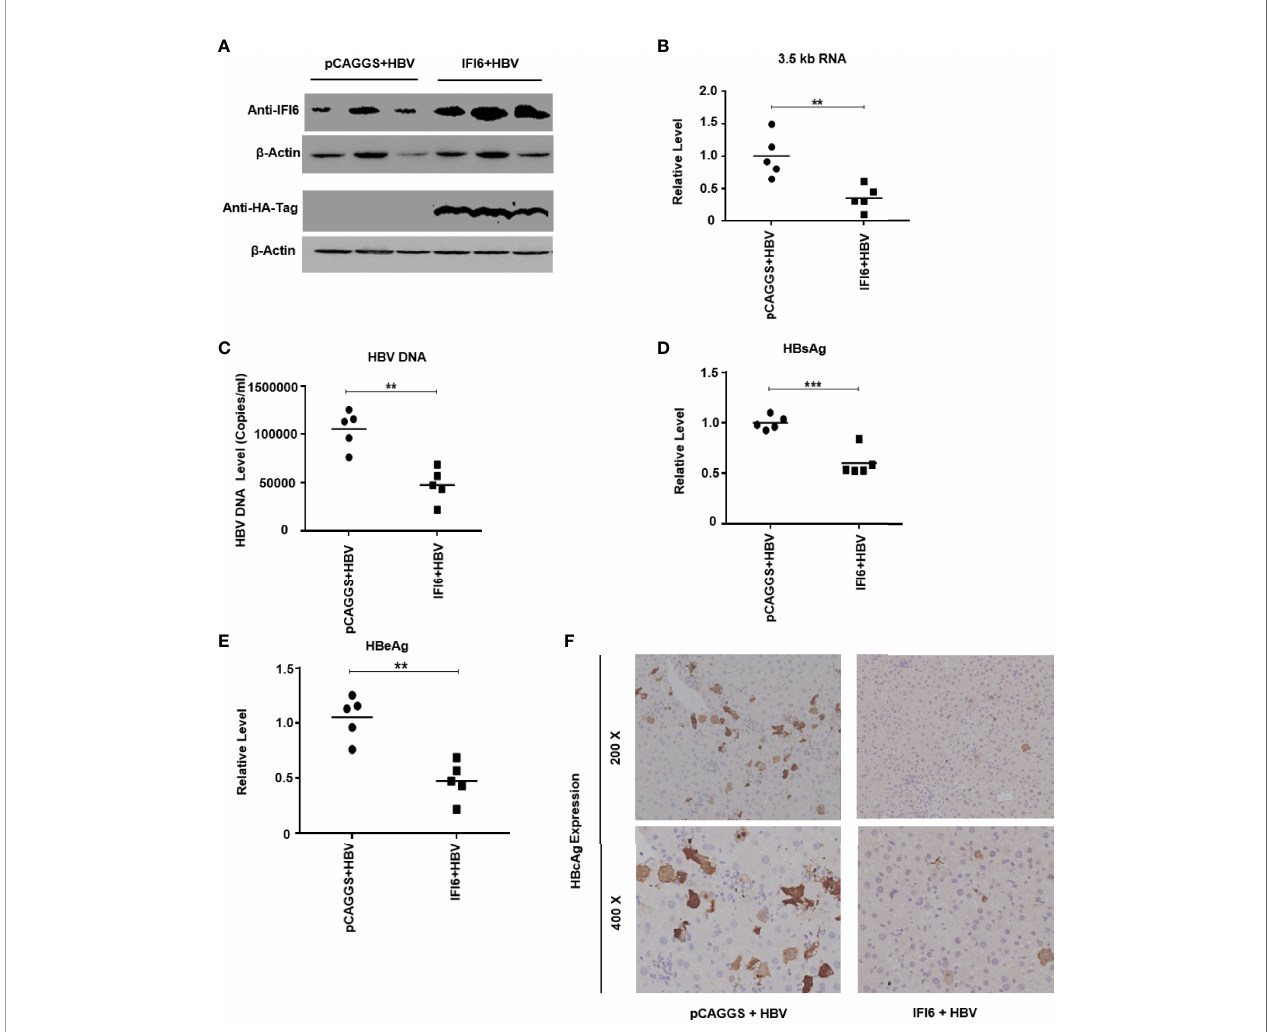
FIGURE 6 | IFI6 inhibits replication of HBV and gene expression in mice. The IFI6 (20 µg) or its control vector (pCAGGS, 20 µg) and pHBV1.3 (10 µg) plasmid were hydrodynamically injected in eight weeks old male C57BL/6 mice. After 5 days post-injection, mice sera and liver were collected. (A) The protein was extracted from mice liver and expression of IFI6 and HA-tag protein was determined with western blot using anti-IFI6 and anti-HA-tag antibody. The b -actin was used as a loading control. (B) The level of 3.5 kb HBV RNA was measured by qRT-PCR. The level of mice GAPDH was used as an internal control. (C) The HBV DNA was extracted from mice serum, and the level was determined by qPCR. The secreted HBsAg (D) and HBeAg (E) were determined with the ELISA. (F) The immunohistochemical staining of HBcAg from mice liver. The data are averages of three independent experiments; the results were measured as a mean ± SD and were statistically measured. ** P < 0.01, *** P <